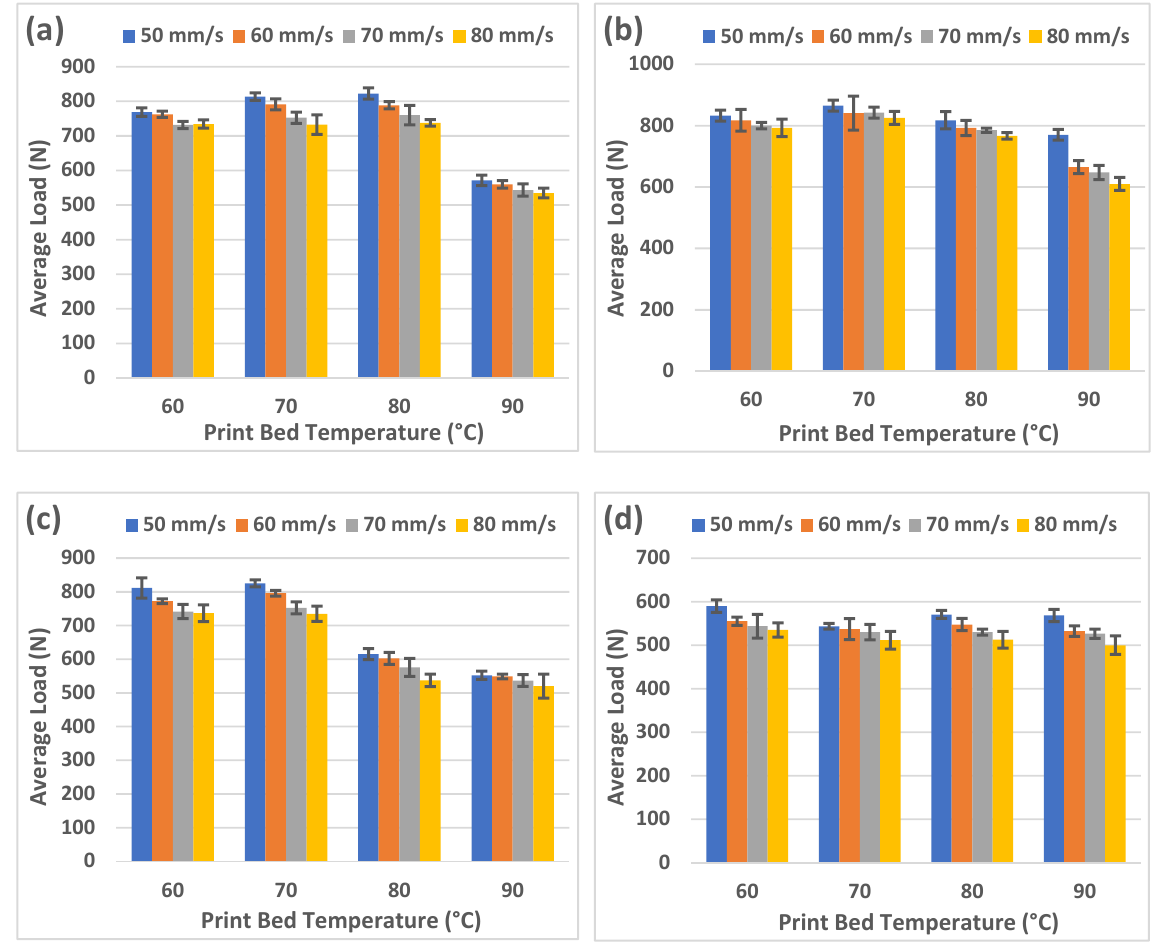
Figure 6. Results from three-point flexural testing at different nozzle temperatures: ( a ) 180 °C; ( b ) 190 °C; ( c ) 200 °C; ( d ) 210 °C.